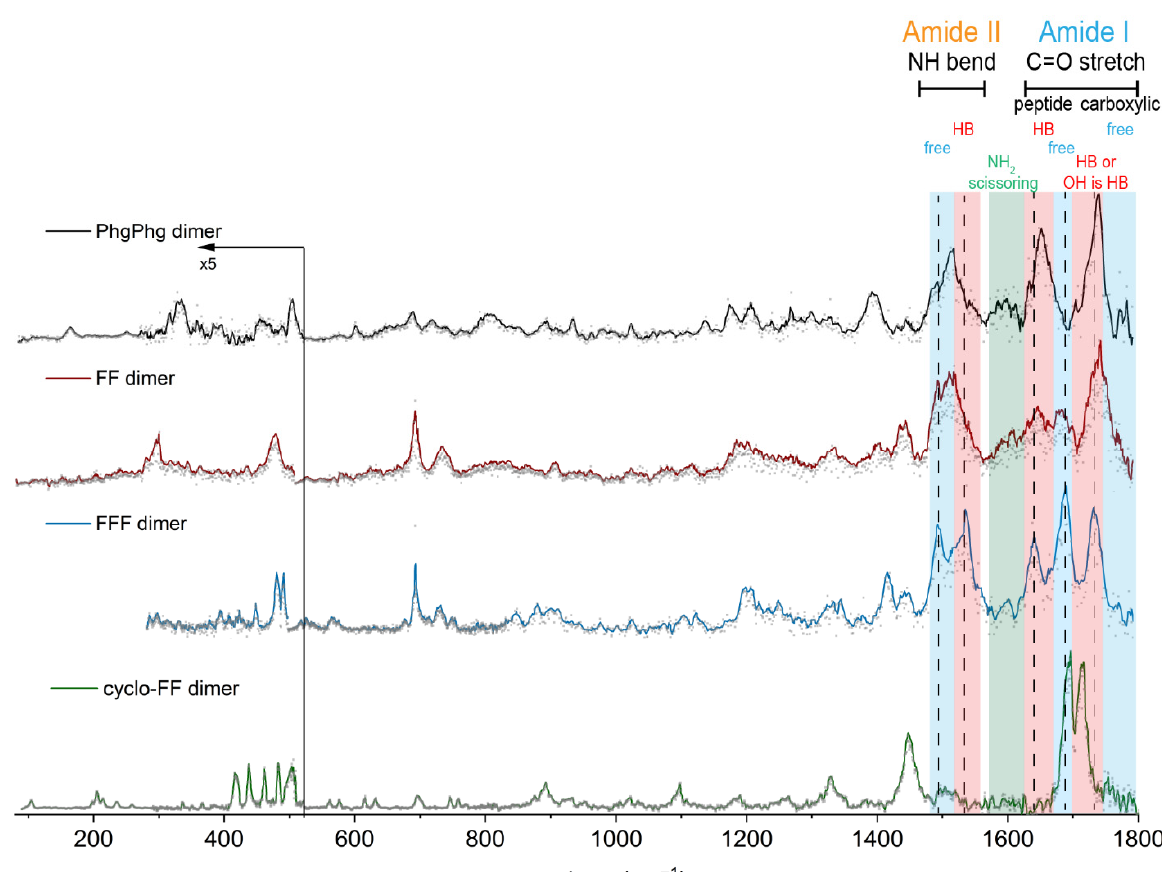
Figure 4. The experimental IR spectra of PhgPhg, FF, FFF, and cyclo-FF dimers (black, red, blue, and green traces, respectively). Grey dots are the averaged data, while solid lines show smoothed data that were obtained using the adjacent-averaging method in Origin software. The far-IR region below about 520 cm − 1 was multiplied by 5 for clarity. The molecular vibrations in the amide I and II regions are shown with blue (free) and red (intermolecular hydrogen bond—HB) boxes. The black dashed lines show the positions of the vibrations of the FFF dimer.